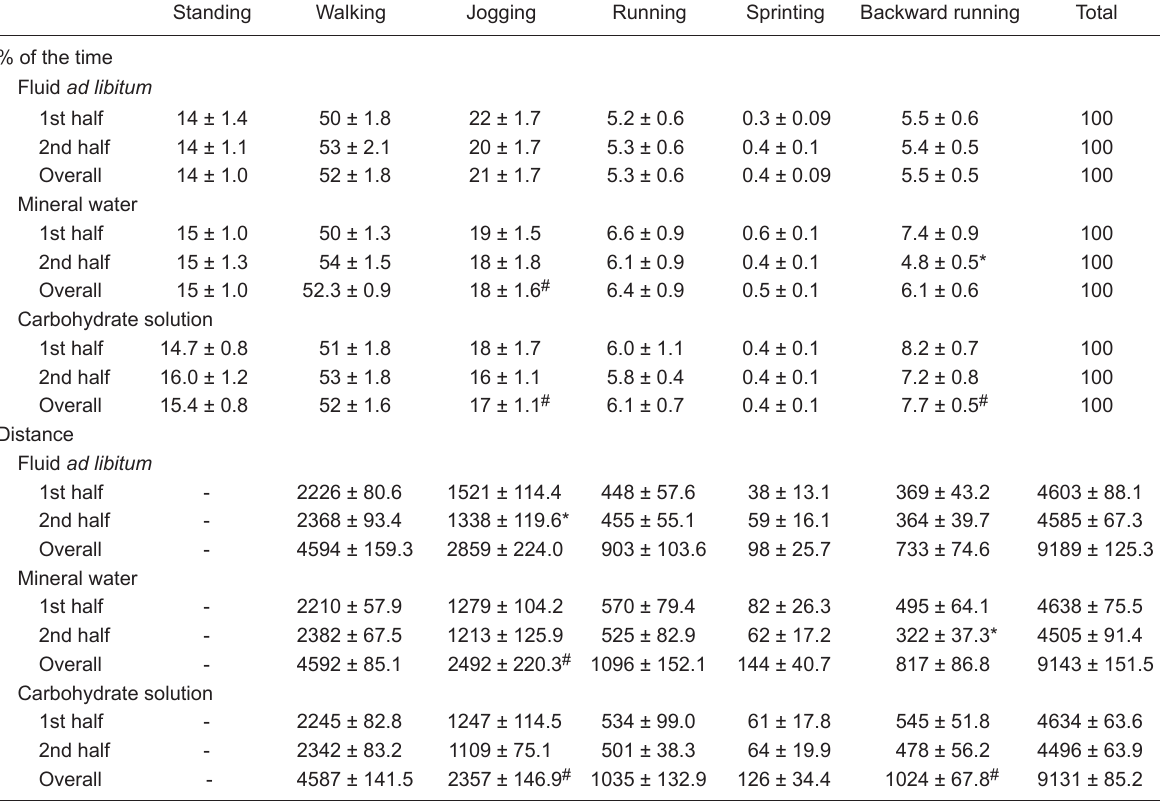
Table 2. Locomotive categories performed and distances covered by football referees under three fluid replacement conditions. Standing Walking